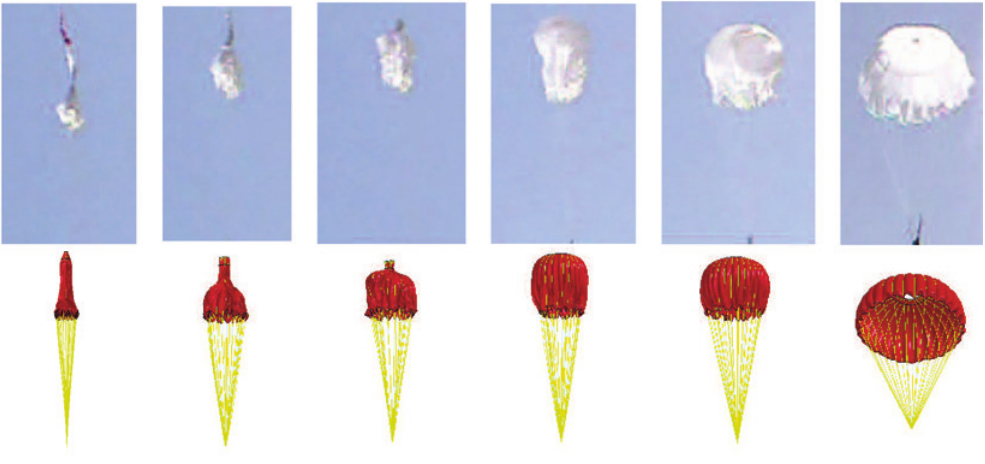
Fig. 9. Comparison between air drop test and